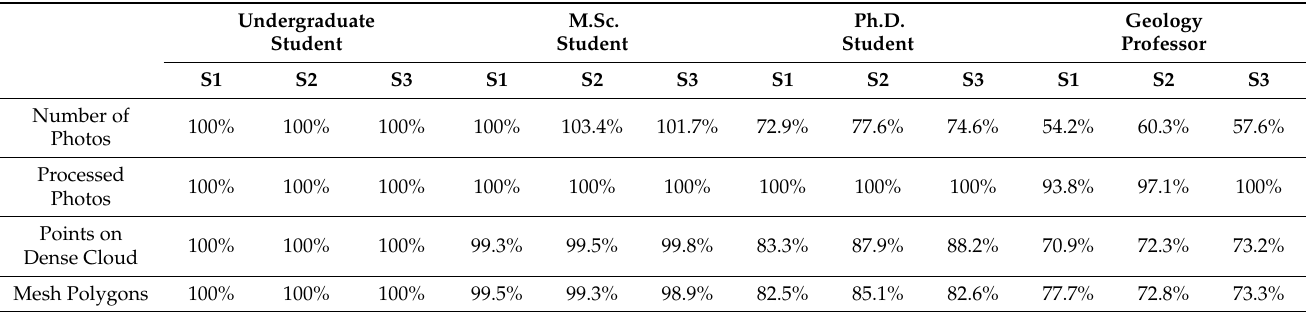
Table 4. Quantitative analysis previous to the complete methodological